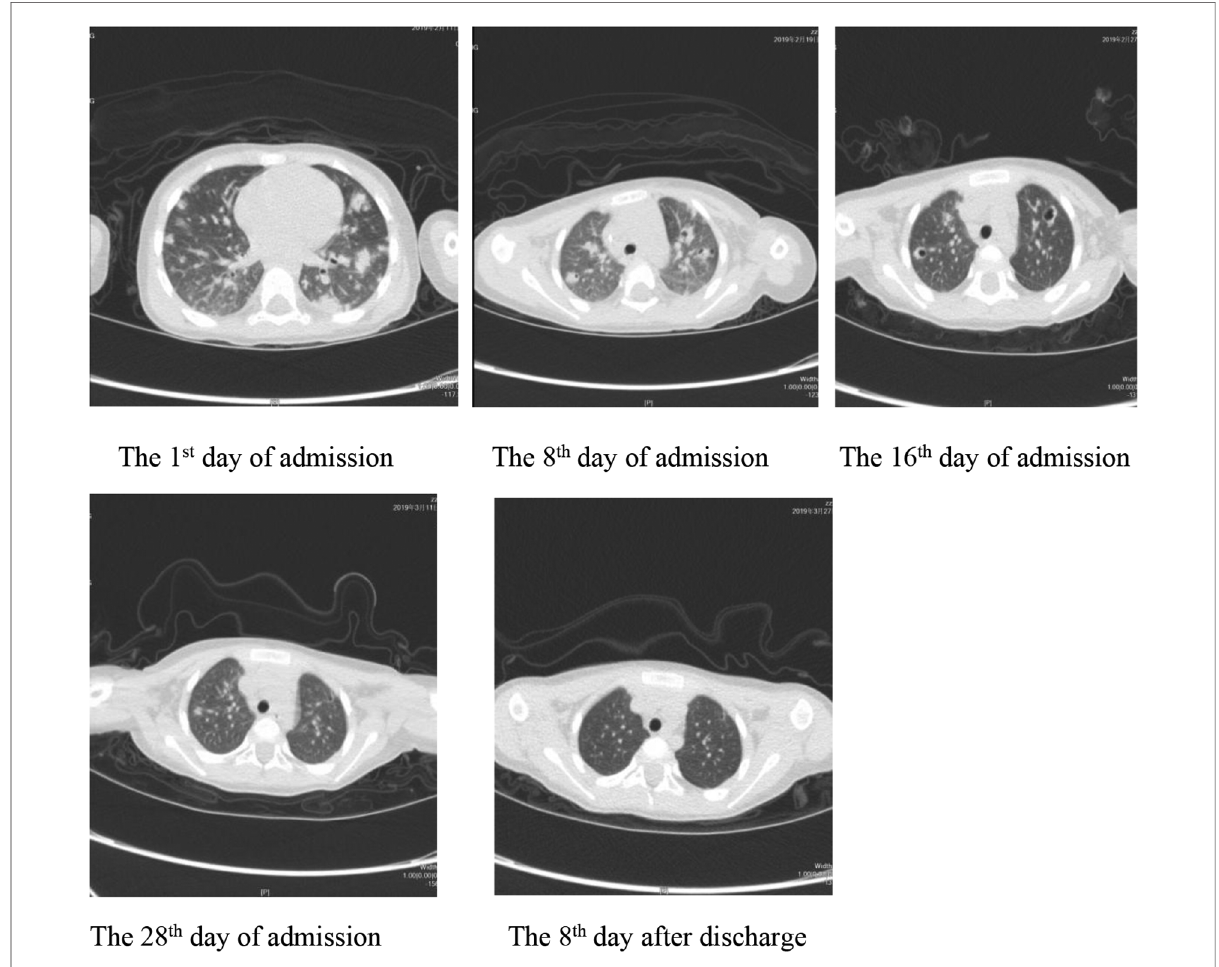
FIGURE 1 Imaging manifestations, transformation, and outcomes of